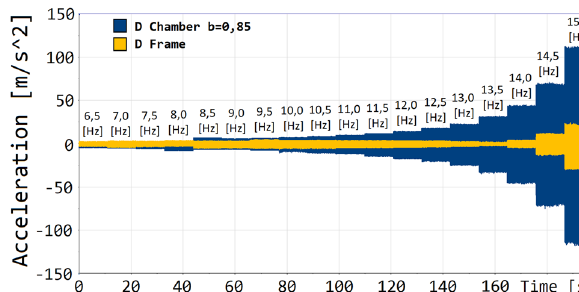
Figure 5: Amplitude – frequency characteristic of the antiresonance mill for the chamber fi lling degree equal to 0.4.